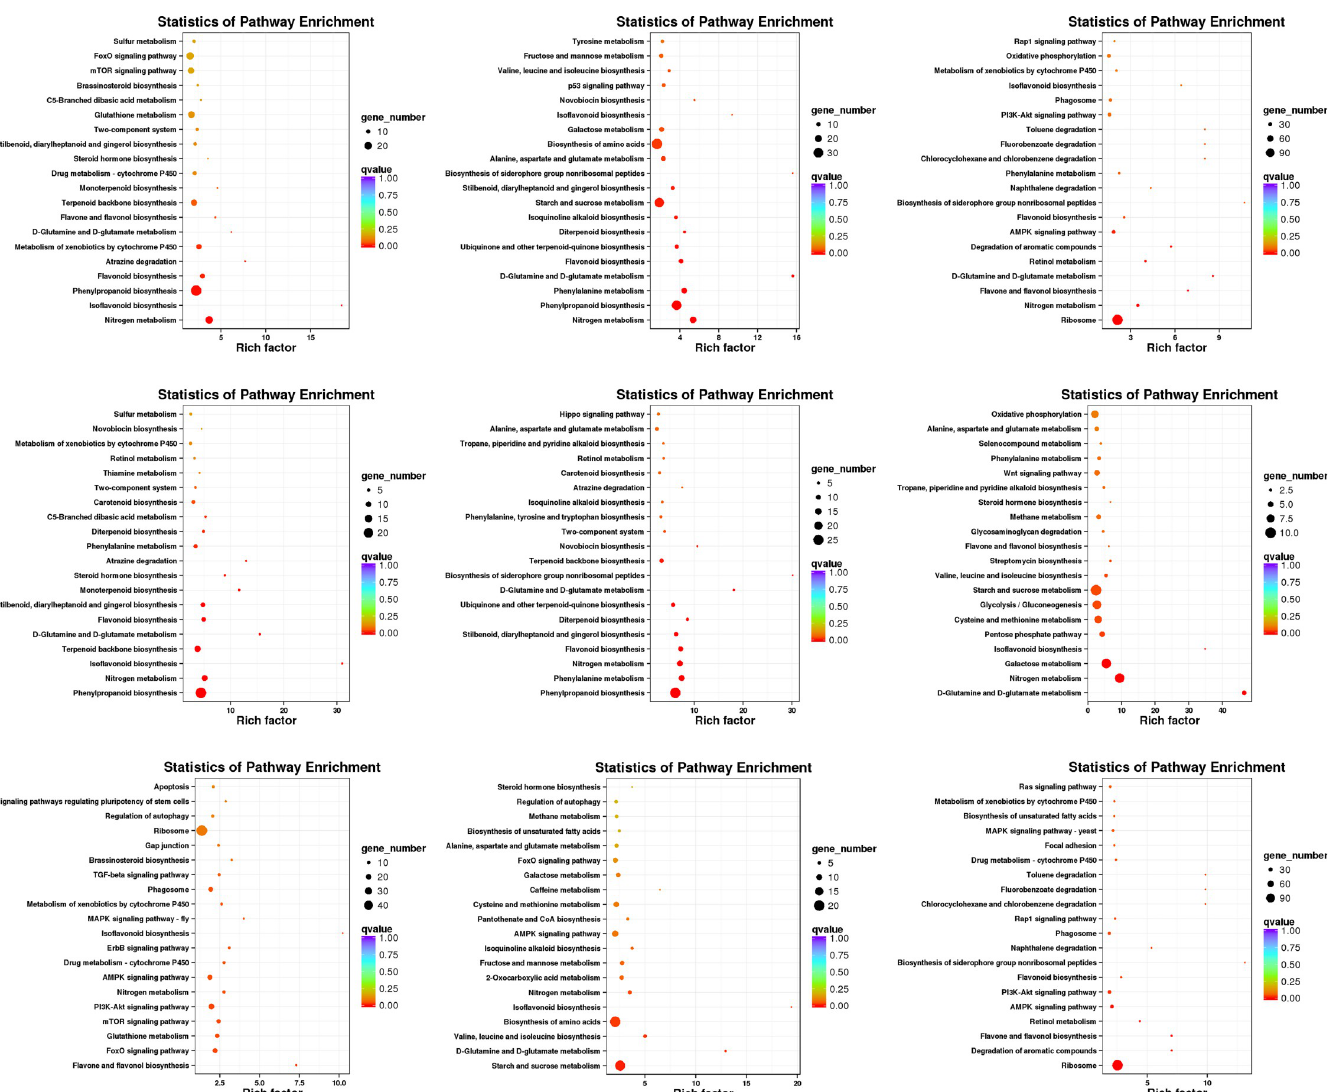
Fig 7. KEGG enrichment pathways in N0 vs. Nf, Nl vs. Nf, and N0 vs. Nl at 75 days after transplanting (DAT). All differentially expressed genes, including upregulated and downregulated DEGs, were distributed in the KEGG pathways. The considerably changed pathways indicate the most abundant dots. The rich factor was the ratio of the number of DEGs in a pathway and the number of all genes involved in this pathway. The degree of gene enrichment was enhanced by increasing rich factor and decreasing (Q-value). The Q-value was the rectified by P-value (FDR). (a) All DEGs in N0 vs. Nf, (b) all DEGs in Nl vs. Nf, (c) all DEGS in N0 vs. Nl, (d) upregulated DEGs in N0 vs. Nf, (e) upregulated DEGs in Nl vs. Nf, (f) upregulated DEGs in N0 vs. Nl, (g) downregulated DEGs in N0 vs. Nf, (h) downregulated DEGs in Nl vs. Nf, (i) downregulated DEGs in N0 vs. Nl.